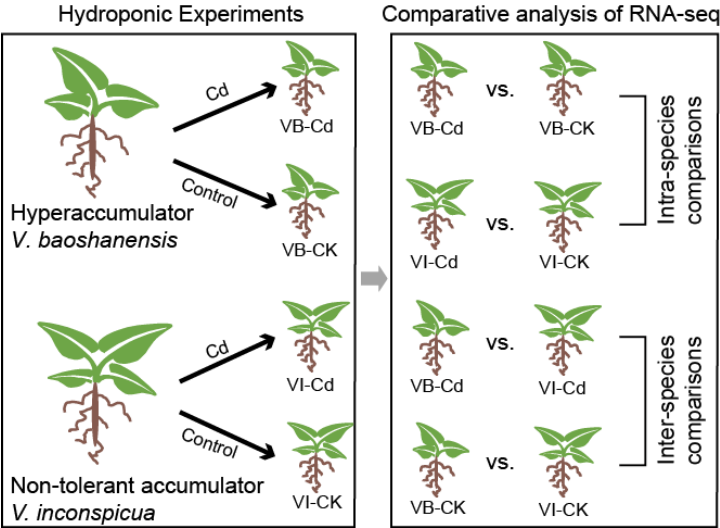
Figure 7. A schematic view of the experimental design for subsequent RNA-seq. VB, V. baoshanensis ; VI, V. inconspicua ; CK, control samples.